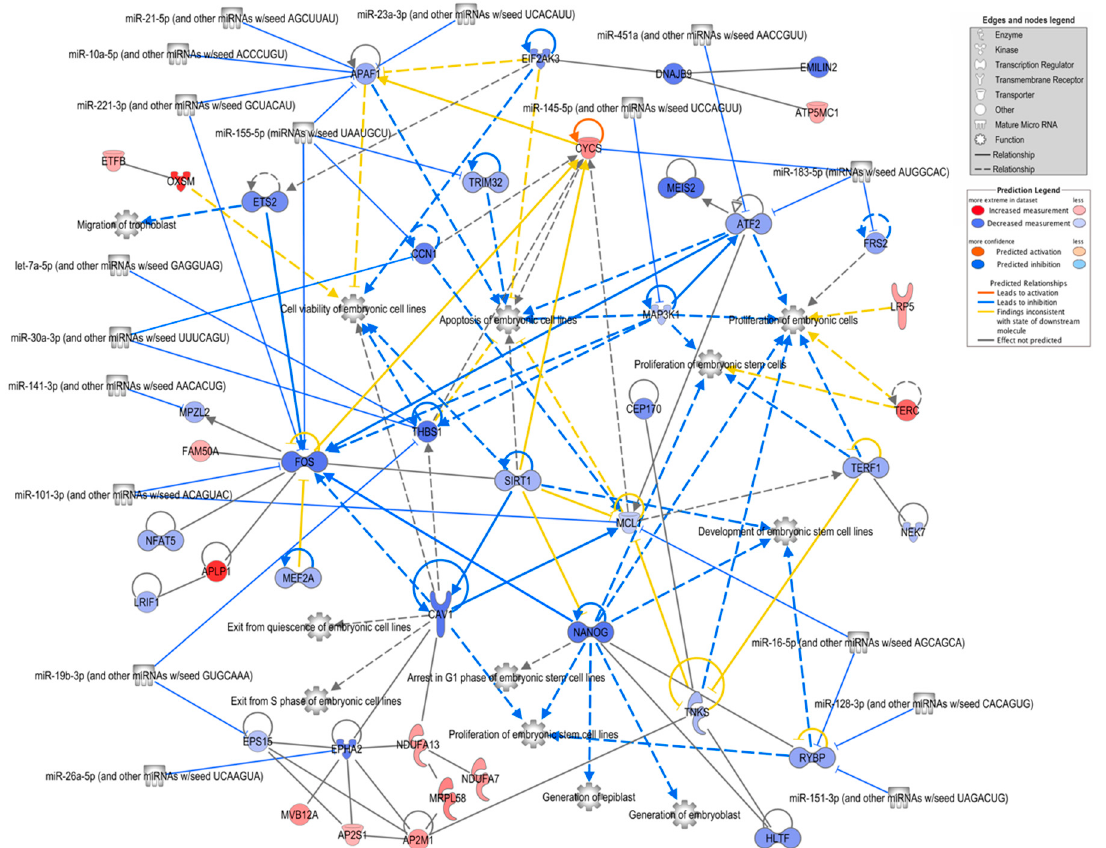
Figure 4. Network of FoEVs vs. Co DEGs involved in embryonic development. A network of overrepresented biological functions related to embryonic development and their assigned FoEV-treated embryos vs. control DEGs was generated using ingenuity pathway analysis software. MicroRNAs revealed by the software to be potential upstream regulators were added to the network (restricted to miRNAs known to be present in bovine oEVs) as well as further connected DEGs. Genes are colored by log2 fold change ratio, blue for downregulated and red for upregulated genes. 2.3. Comparative and Integrative Analysis of Embryonic mRNAs Altered under oEV Treatment and oEV- Derived mRNAs.